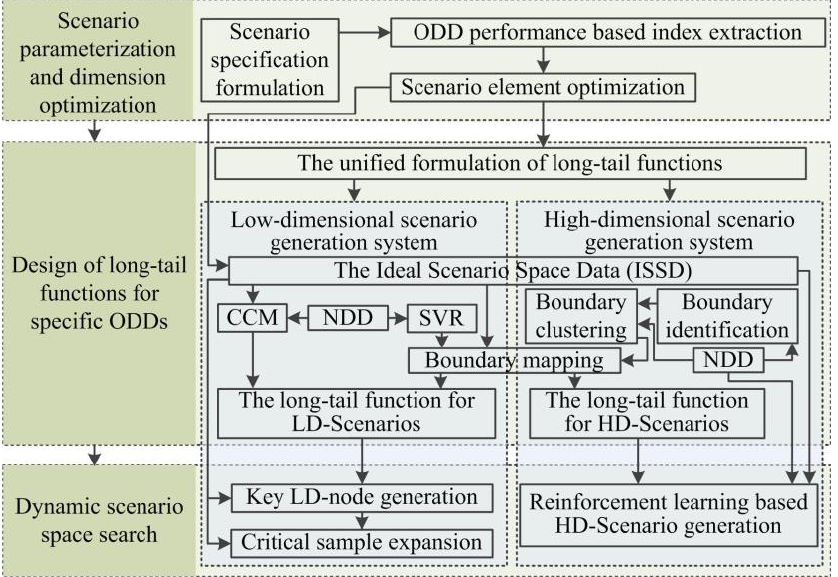
Figure 1. Framework of the dynamic scenario generation system.